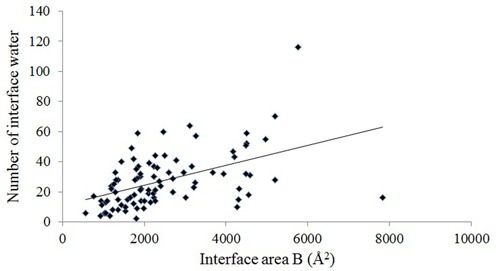
The number of interface water molecules is plotted against the interface area B in protein–RNA complexes.